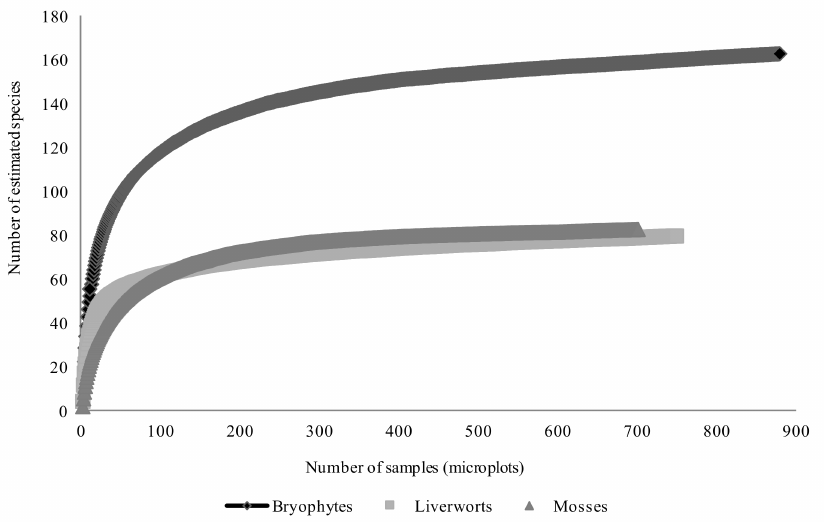
Figure 2. Mean species accumulation curves for bryophytes, liverworts and mosses of Pico Island using a Jackknife 1 estimator, based on 999 randomized